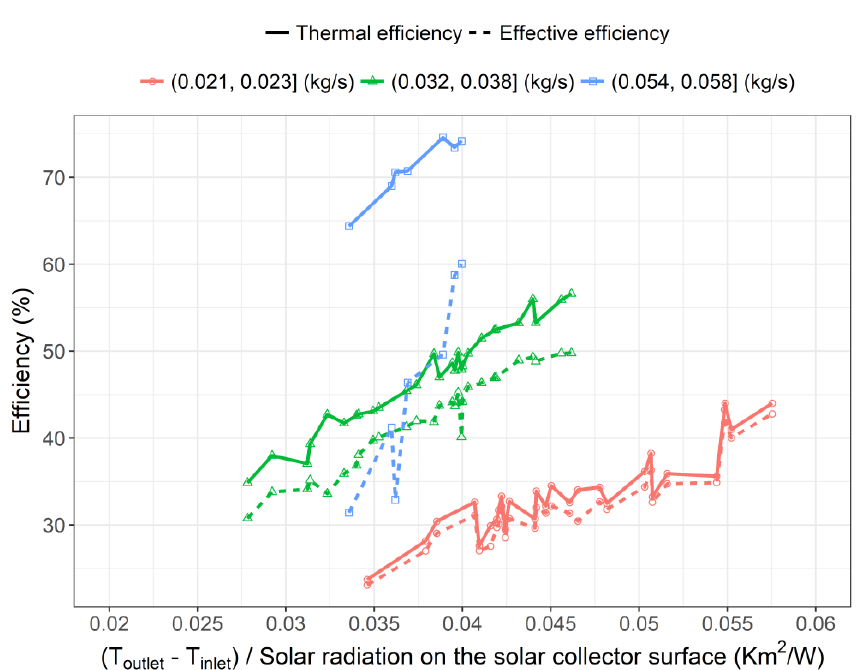
Figure 6. Thermal efficiency and effective efficiency of the solar air heater versus the value of the efficiency function at different air mass flow rate. The efficiency function is the temperature difference between outlet air (T outlet ), and inlet air (T inlet ) divide the solar radiation on the collector panel (I T ).